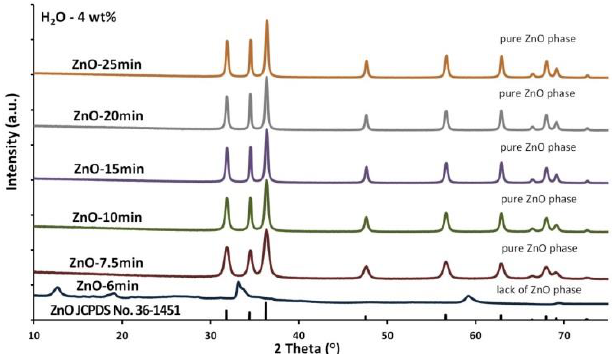
Figure 49. XRD di ff raction patterns of ZnO NPs synthesis products obtained from the 4% H 2 O precursor, for synthesis durations of 6, 7.5, 10, 15, 20, 25 min and its comparison with the standard pattern of ZnO in wurtzite phase (JCPDS card No. 36-1451). Republished with permission of © IOP